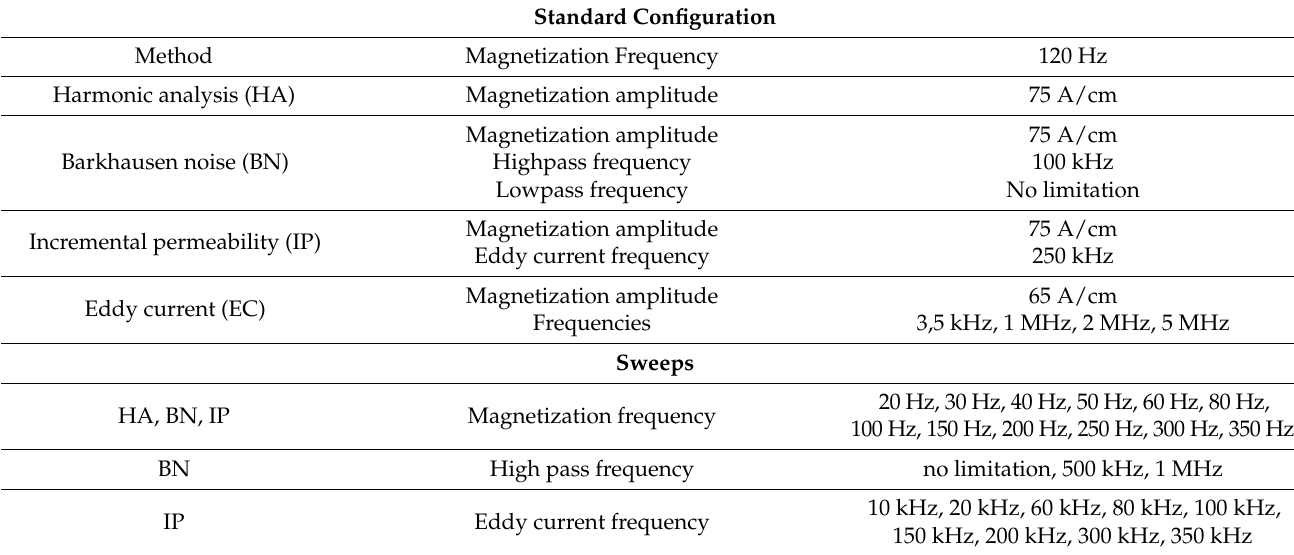
Table 4. Configuration of the